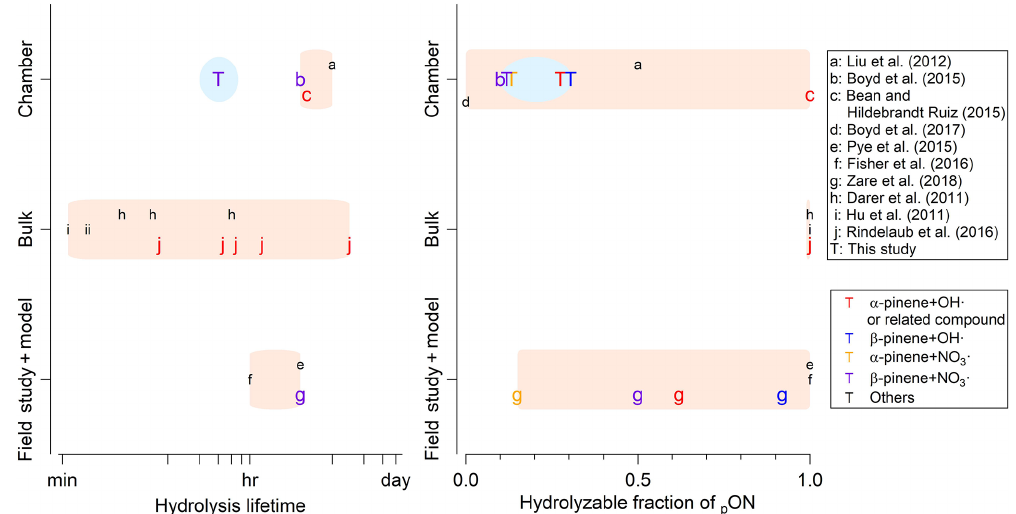
Figure 5. Comparison of hydrolysis lifetime of organic nitrate and hydrolyzable fraction of p ON in literature. “Chamber” refers to laboratory studies of organic nitrate aerosol via chamber experiments, “Bulk” refers to laboratory studies of organic nitrate compounds using bulk solution measurements, and “model” refers to modeling studies using ambient measurement data as constraints. Data points are colored by the system of VOC and oxidant condition and are alphabetized based on the reference. The relevant systems explored in this study are emphasized by enlarging the corresponding font size. Pink shaded regions are ranges reported in literature, while blue shaded regions are ranges reported in this study.